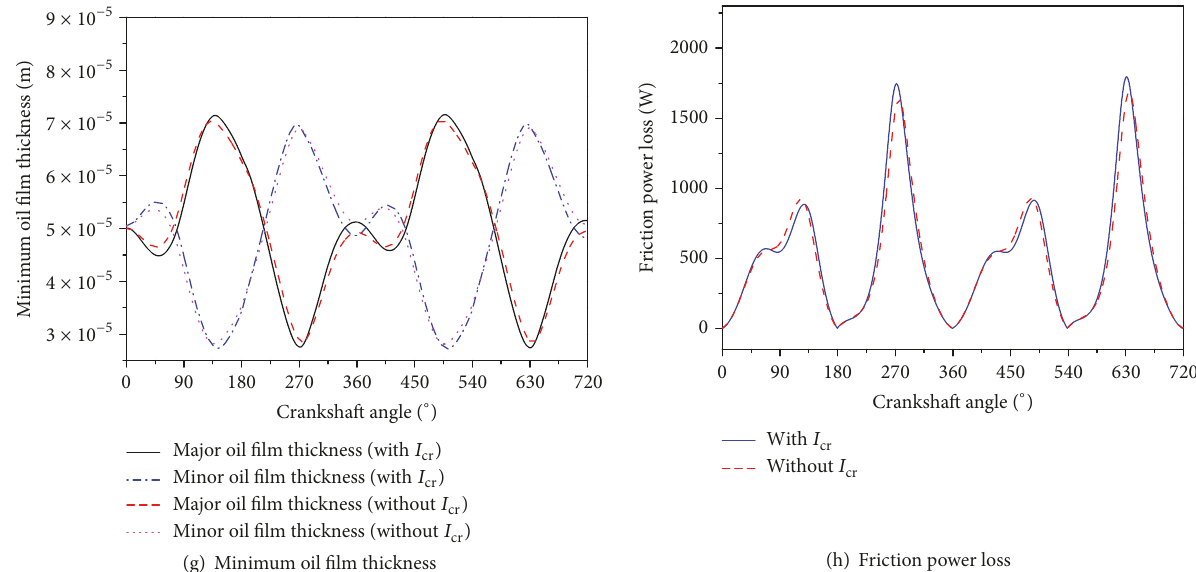
Figure 10: Effect of connecting rod inertia on secondary motion.